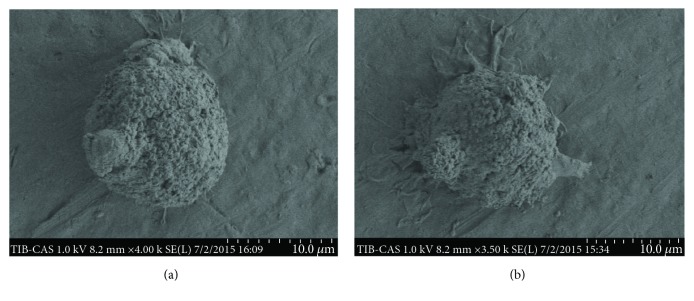
mDCs were visualized identified by SEM: (a) the shape of typical round mDCs after PKM2 siRNA transfection (original magnification: 5000x); (b) a more matured mDC in the siRNA-control group (original magnification: 5000x).